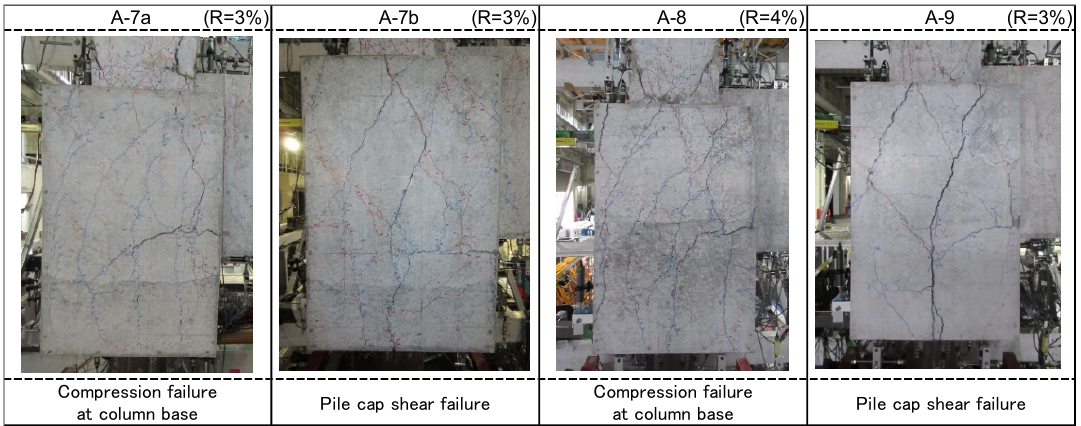
Figure 3. Failure mode at end of test.